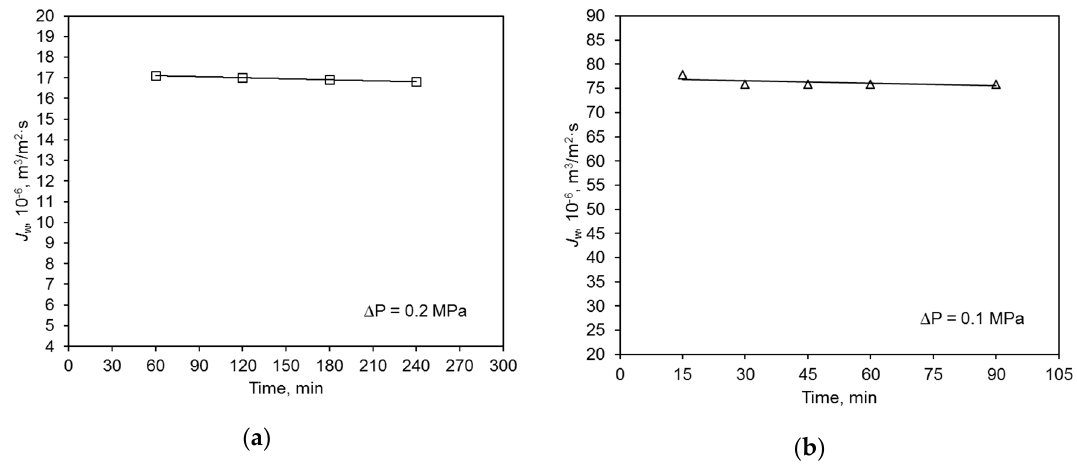
Figure 3. Hydraulic membrane capacity for deionized water: ( a ) polymer membrane, ( b ) ceramic membrane.